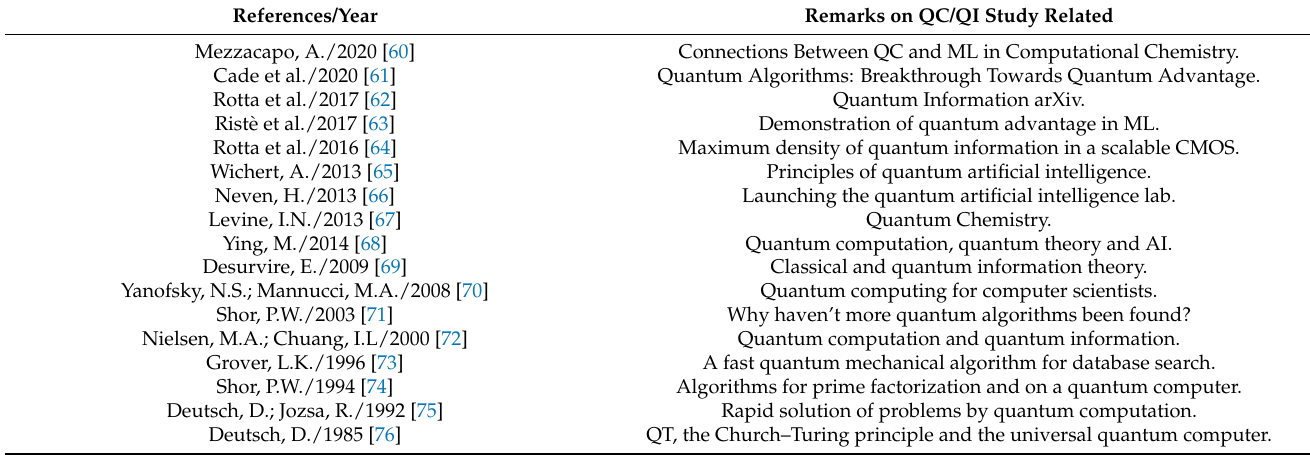
Table 4. Summary of the Literature Review on quantum computing (QC) and quantum Intelligence